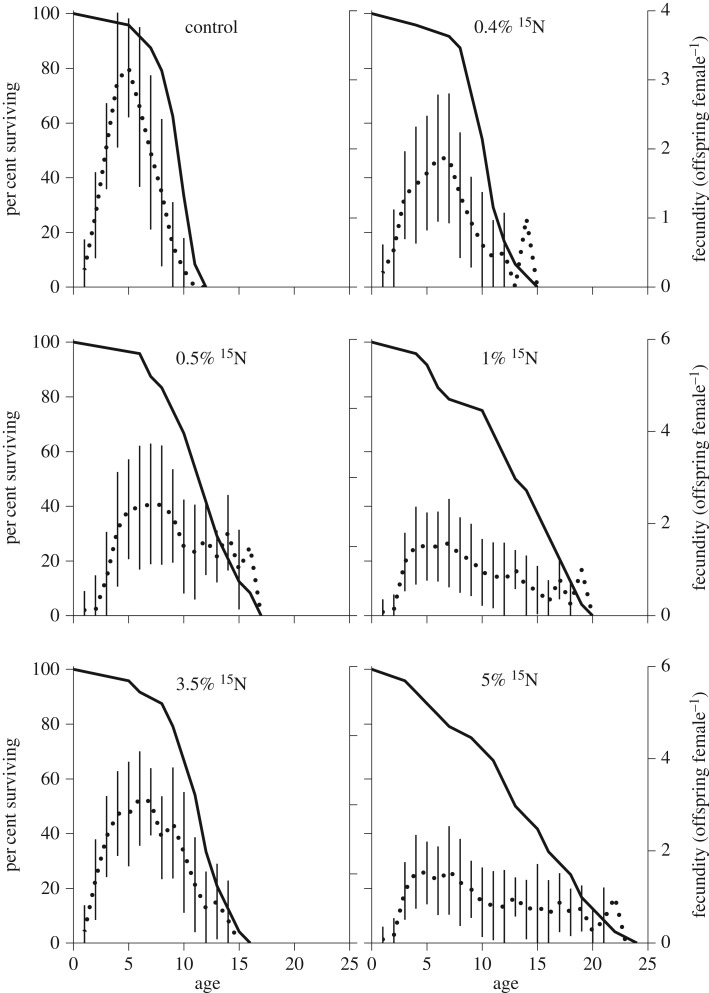
Survival (solid line) and age-specific fecundity (dotted line, mean and standard deviation) of the rotifer Brachionus plicatilis fed algal diets with varying 15N-enrichment (0.4 to 5%); non-enriched algae were used as the control diet. See electronic supplementary material, tables S1–S5 for statistical comparisons and electronic supplementary material, table S6 for primary data.